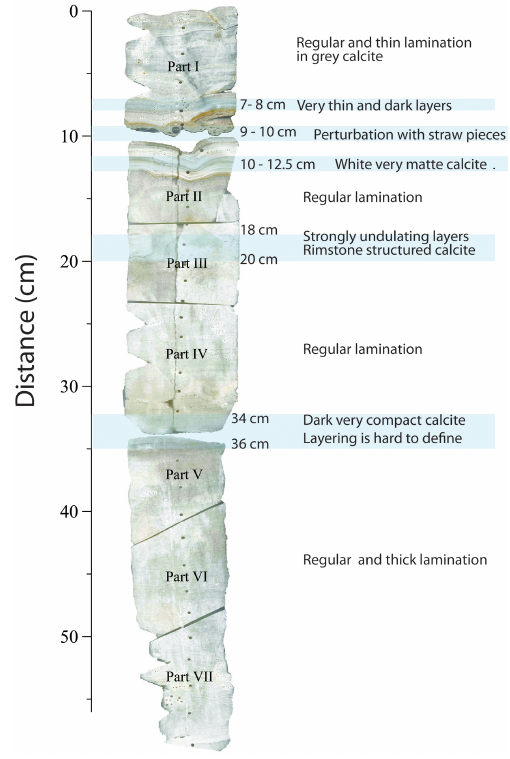
Figure 2. The upper laminated 56cm of the Proserpine core with the description of the calcite aspect. The blue bars indicate intervals during which calcite deposition is disturbed or calcite aspect is very dark and compact or white and